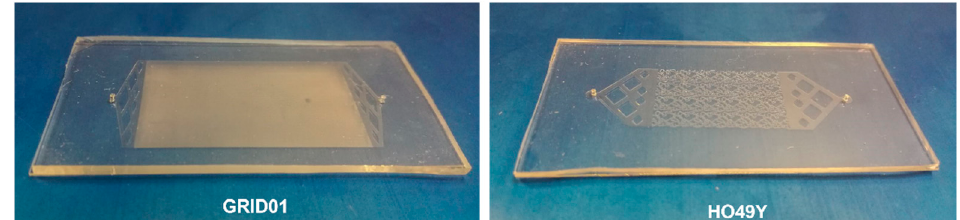
Figure 8. PDMS-glass microfluidic devices.